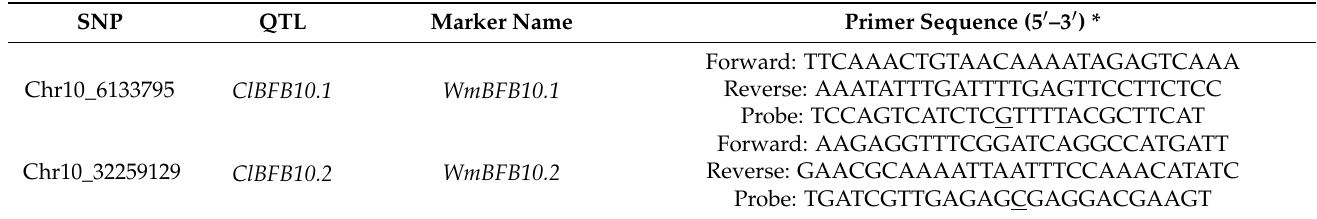
Table 2. Primer sequences of SNPs associated with BFB resistance in